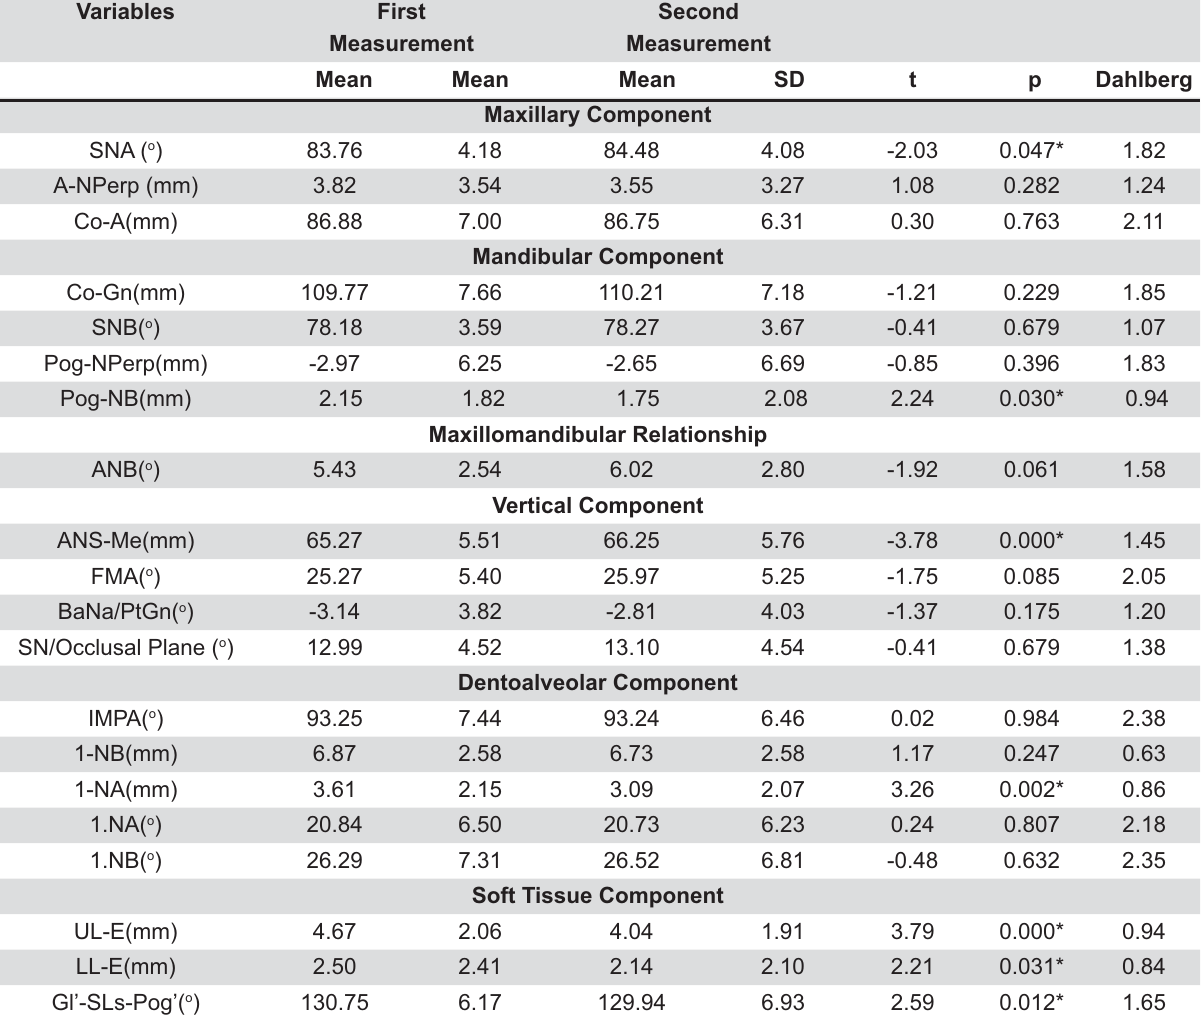
Table 1- Results of systematic and casual errors investigation for manual tracings